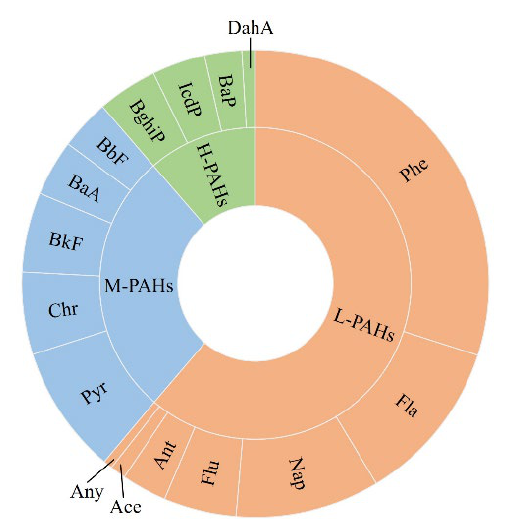
Figure 1. PAH contents in soil near the lake shores. ( a ) Total PAH content in soil; ( b ) PAH monomer content in soil.